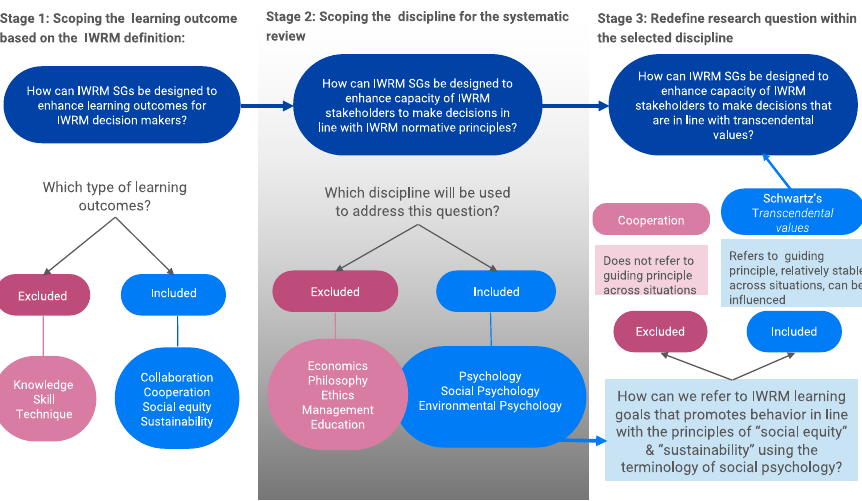
Figure 1. Conceptualization of the following research question: how can serious games (SGs) for integrated water resource management (IWRM) be designed to enhance the capacity of IWRM stakeholders to make decisions that are in line with IWRM’s normative principles?